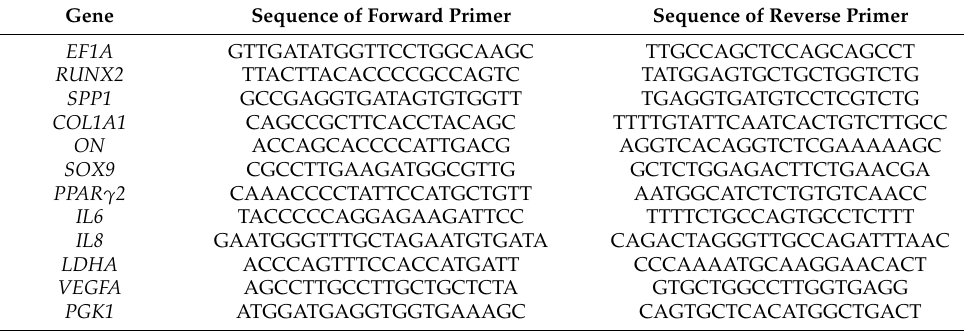
Table 2. Sequences of primers used for